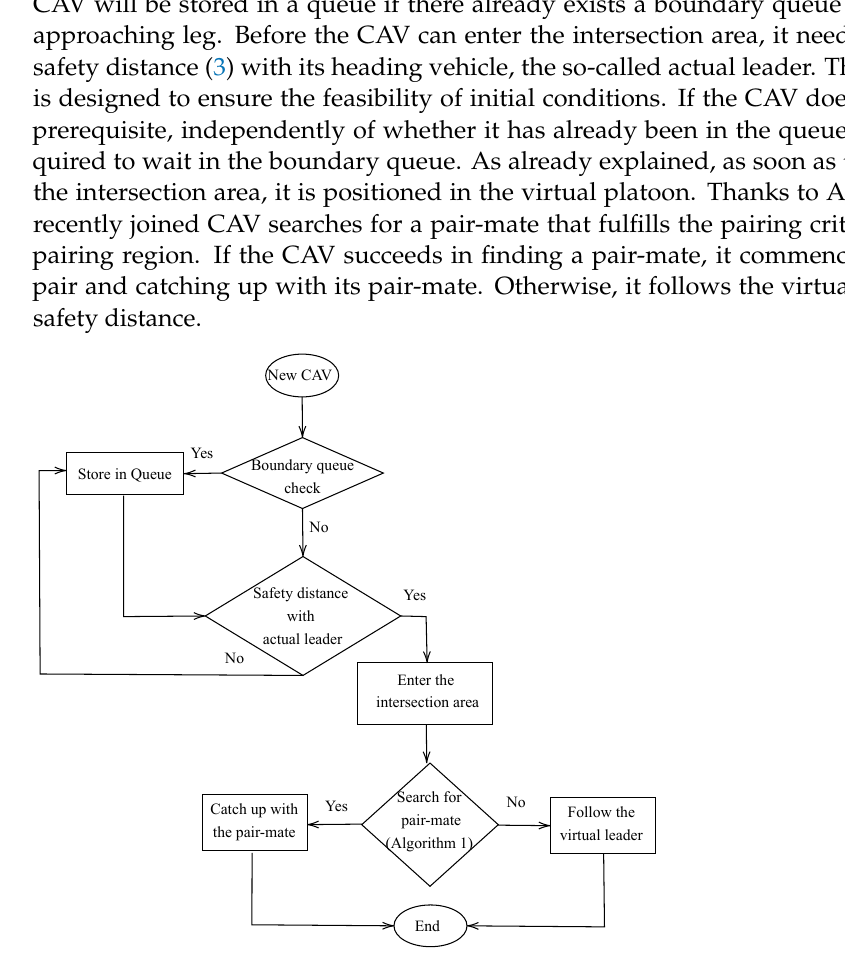
Figure 2. CAV’s procedure for positioning in the virtual